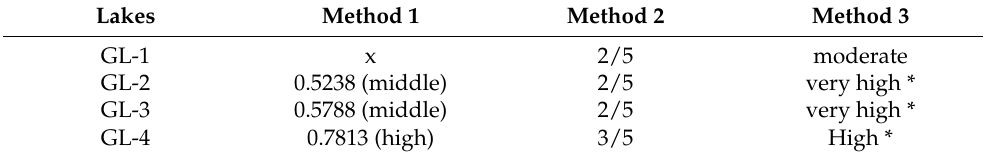
Table 7. Results from three different methodologies for outburst susceptibility used in this study. Lakes Method